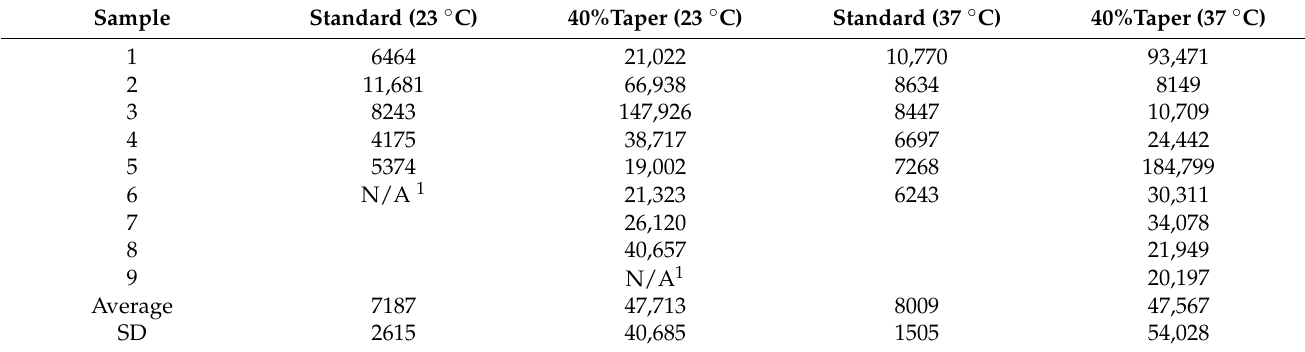
Table 2. Fatigue cycle number at fracture from rotating bending fatigue